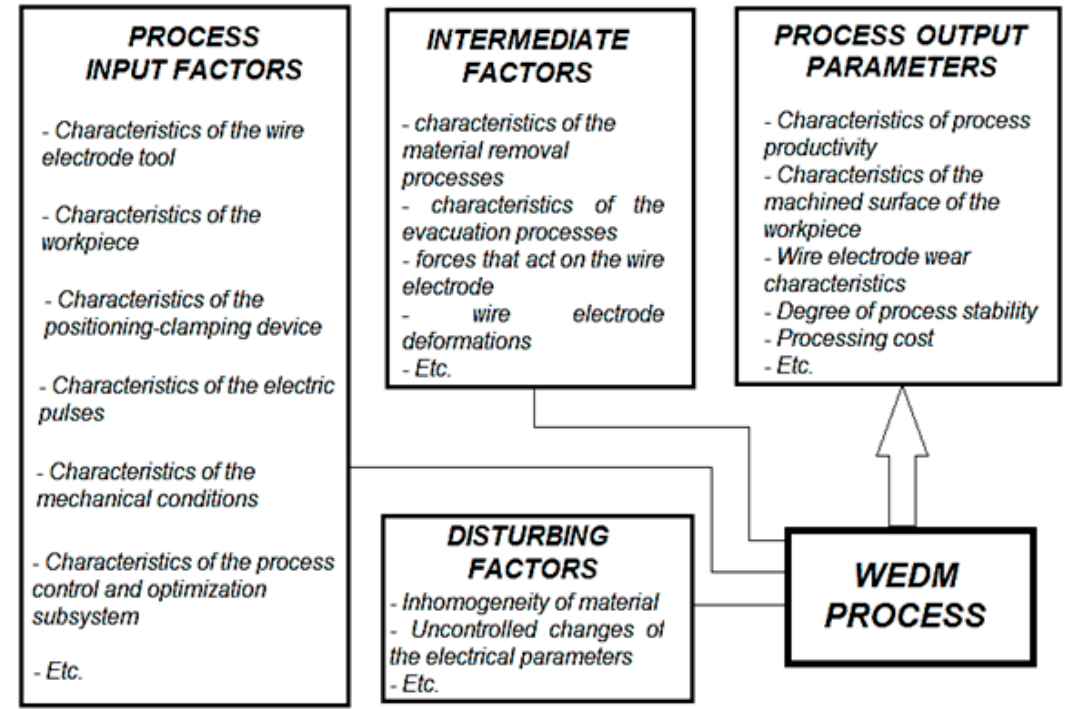
Figure 8. Several factors and groups of factors highlighted when analyzing WEDM as a